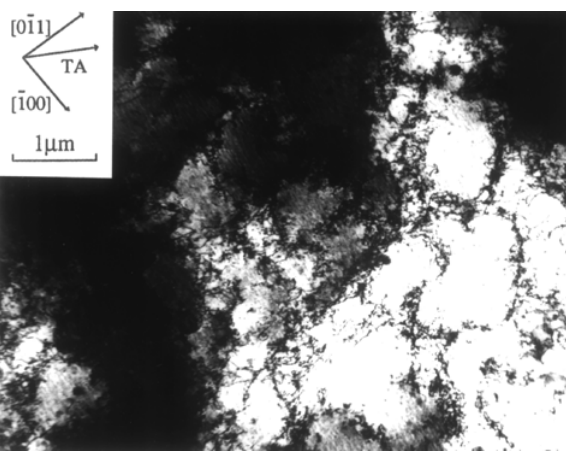
Figure 5. TEM observation of unorganized dislocation structure, devel- oped during the second path in tension (strain approximately equal to 0.02) in a grain with <1 1 0> axis normal to the sheet plane. The prestrain value in rolling is equal to 0.16 (TA, tensile axis).